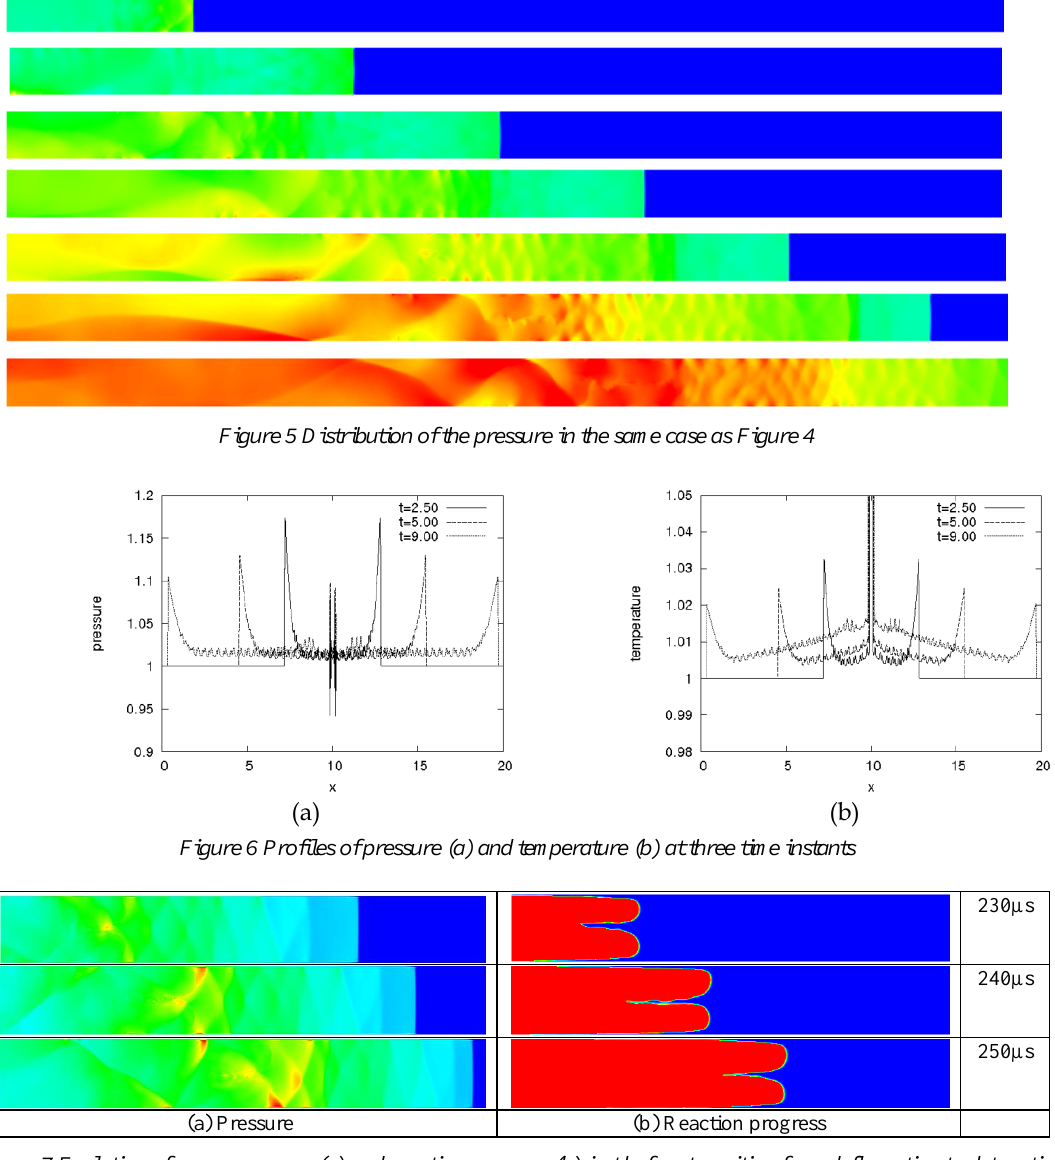
Figure 7 Evolution of pressure waves (a) and reaction progress (b) just before transition from deflagration to